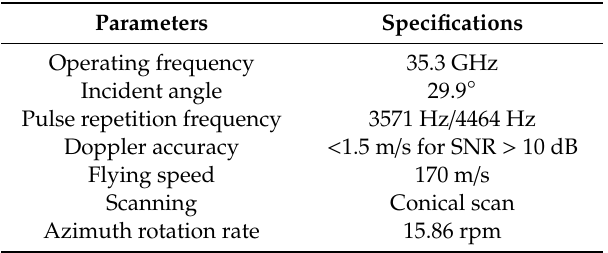
Table 4. Partial system parameters of the High-Altitude Imaging Wind and Rain Airborne Profiler (HIWRAP) Ka-band radar